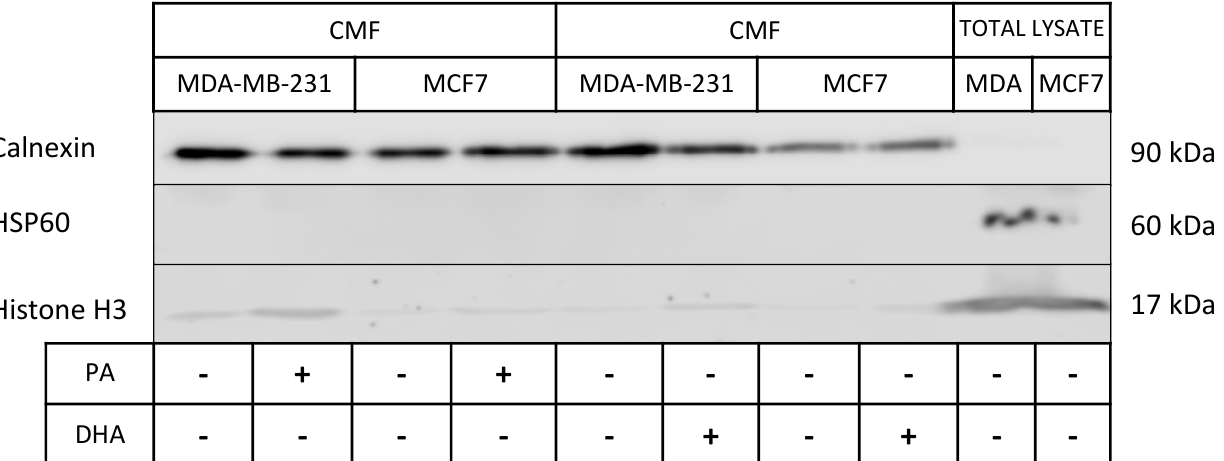
Figure 5. Percentage distribution of fatty acids from ER fractions purified from MDA-MB-231 ( a ) and MCF7 cells ( b ), treated with PA and DHA (50 µM) for 72 h: data are represented as mean ± SE of four independent experiments. (* p < 0.05, ** p < 0.01, and *** p < 0.001 vs. Ctr cells of the same line). SFA, saturated fatty acids; MUFA, monounsaturated fatty acids; PUFA, polyunsaturated fatty acids (=sum of n-6 and n-3 PUFA); n-6 PUFA, omega-6 polyunsaturated fatty acids; and n-3 PUFA, omega-3 polyunsaturated fatty acids.